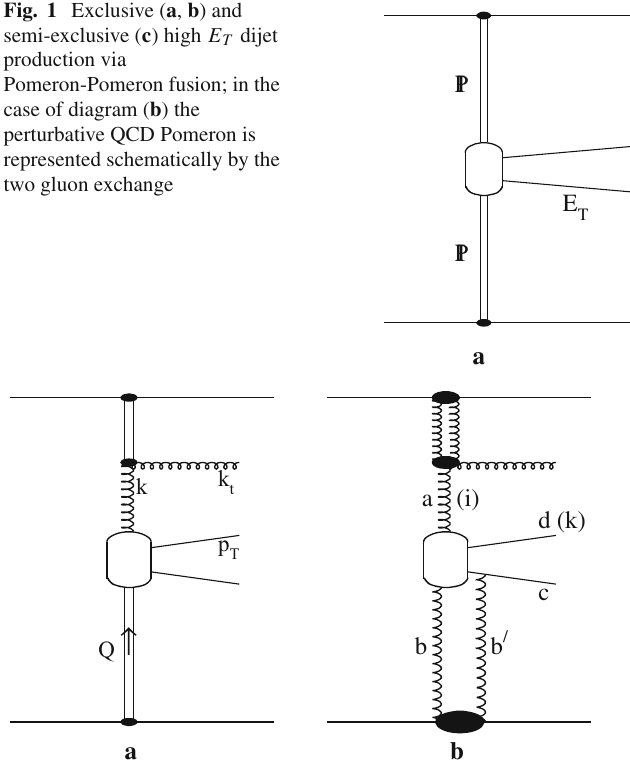
Fig. 2 Diagrams for three jet production via the fusion of a ’soft’ (upper) and the ’hard’ Pomeron. Two highest p T jets are produced in the fusion of a ’hard’ Pomeron with the parton (shown as a gluon) fromthesoftPomeronPDF.Themomentatransferredtothehardmatrix element by the hard Pomeron ( Q ) and the parton from the soft Pomeron ( k ) together with the momenta of produced jets are indicated in a while the colour indices of the incoming and outgoing gluons (quarks) are shown in b